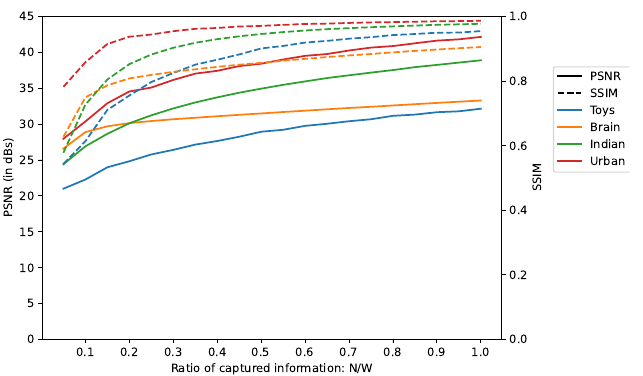
Figure 7. PSNR and SSIM depending on the quantity of captured information. N and W stand for the number of acquisitions and the spectral dimensions of the scene,